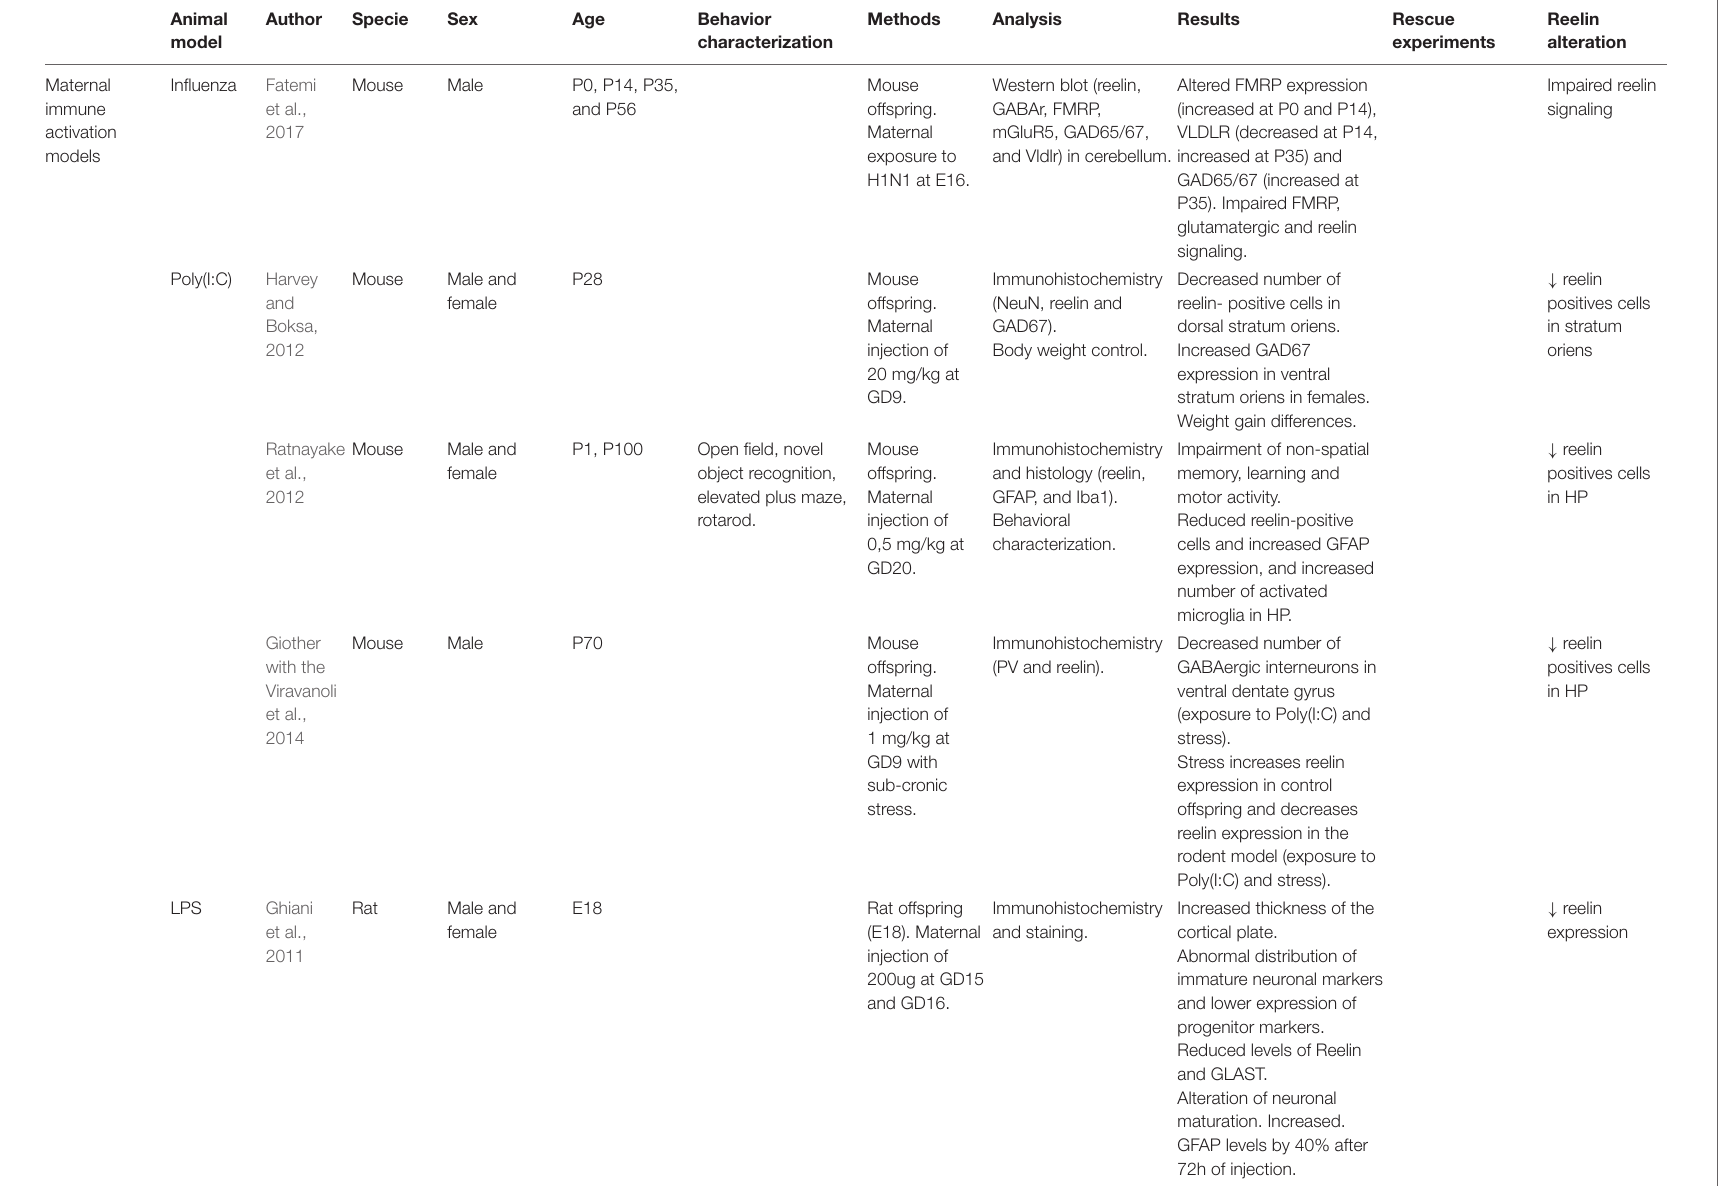
TABLE 2 | Principal findings of MIA model studies included in this